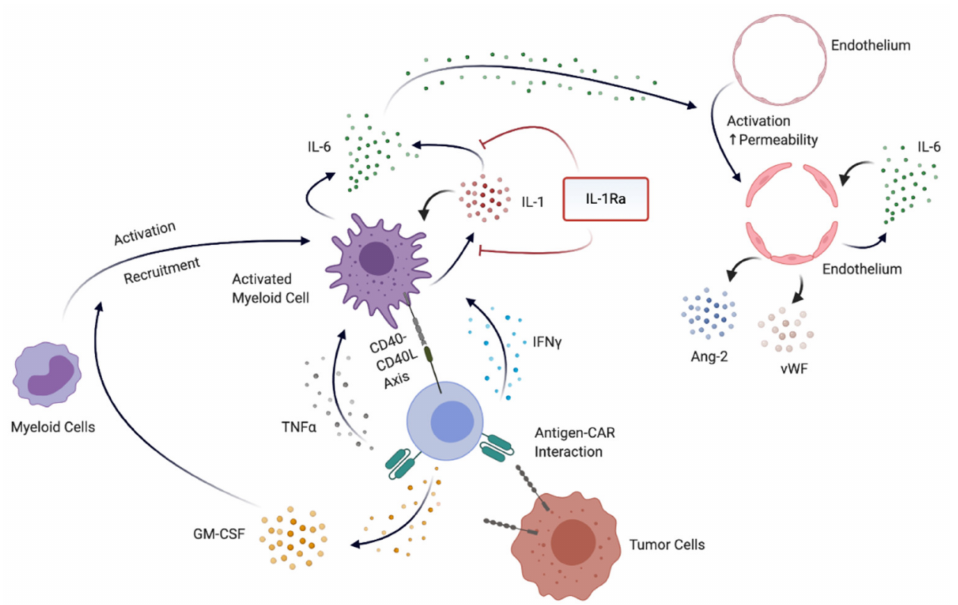
Figure 3. Mechanism leading to CRS and ICANS and potential role of IL-1 blockade. Activated CAR T cells induce cytokine production from myeloid cells through different mechanism: (1) direct interactions between CD40-expressing myeloid cells and CD40L+ T cells or (2) indirect interactions via secretion of proinflammatory cytokines (e.g., GM-CSF, TNF α , IFN γ ). Activated myeloid cells produce high amounts of cytokines such as IL-1 and IL-6, which subsequently activate endothelial cells and disrupt vascular integrity. Endothelial cell-derived mediators (e.g., Ang-2 and vWF) can further stimulate endothelial cells, increase permeability and induce coagulopathy. IL-1-receptor antagonists are under investigation to inhibit the IL-1–IL-6 pathway. CRS, cytokine release syndrome; GM-CSF, granulocyte macrophage-colony stimulating factor; ICANS, immune effector cell-associated neurotoxicity; TNF α , tumor necrosis factor alpha, IFN γ , interferon gamma; IL-1Ra, IL-1 receptor antagonist; Ang-2, angiopoietin-2; vWF, von Willebrand factor. Together, these mechanisms induce a hyperinflammatory syndrome with high serum levels of IL-6, TNF- α and other cytokines (e.g., IL-2, IL-8, IL-10), which can result in